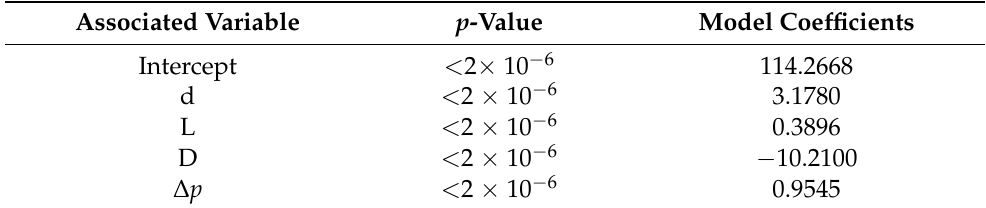
Table 4. Model coefficient and significance analysis: pressure force.